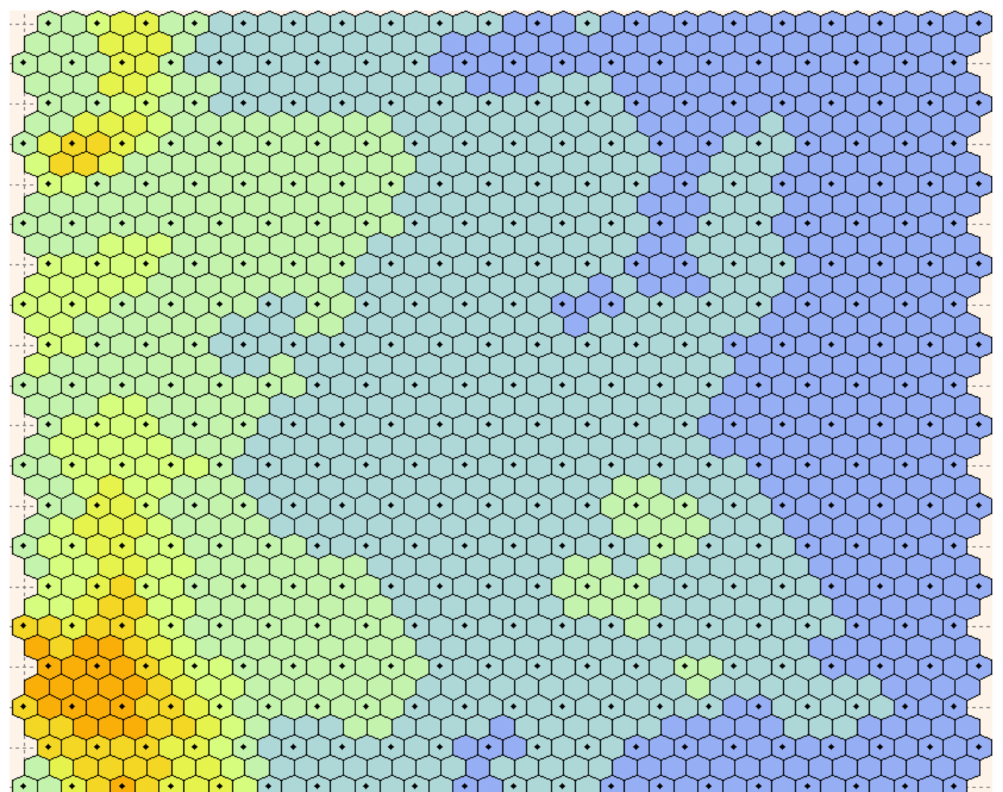
Figure 11. U-matrix for the 11 inputs (shown in Figure 12). Cool colours indicate small distances between data points (clustering), warm colours represent large distances between data in multidi- mensional space. SOM maps generated in ML Office